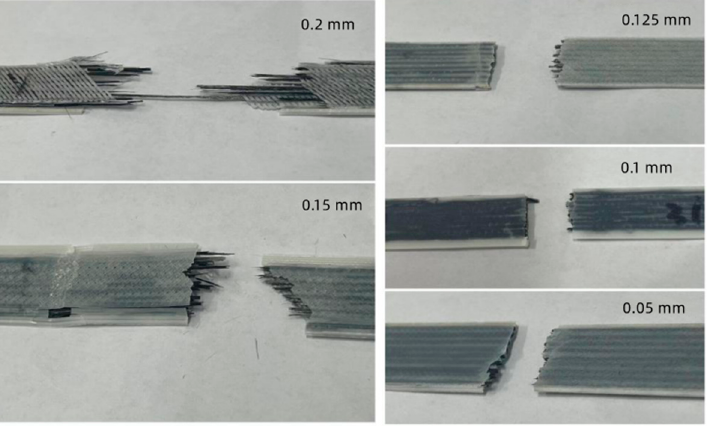
Figure 6. Fracture comparison between print specimens with different fiber thickness.